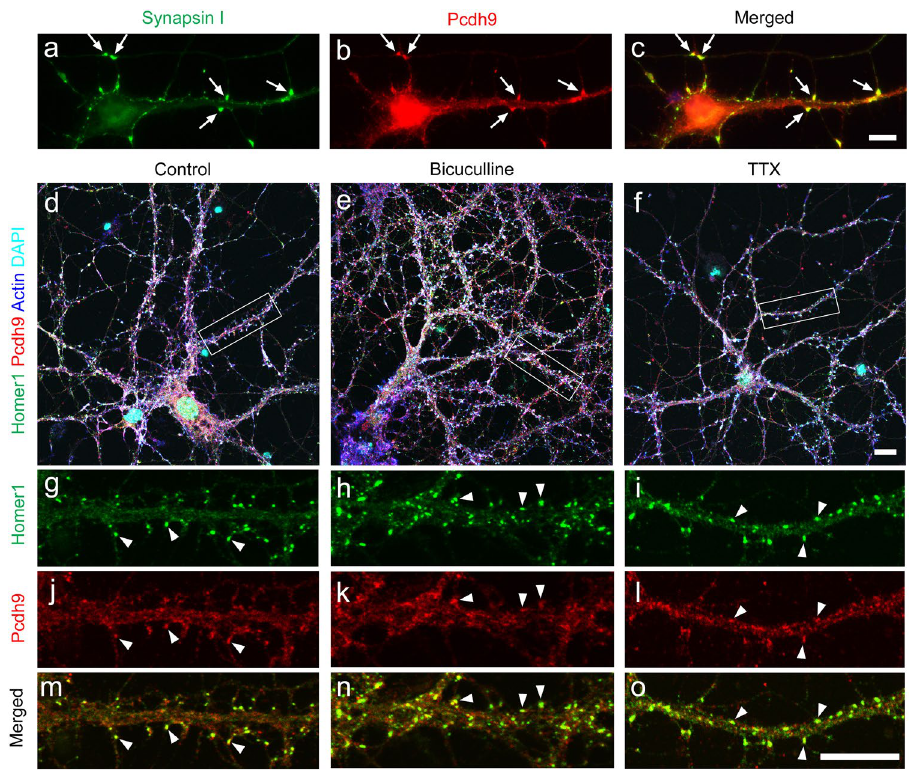
Figure 3. Localization of Pcdh9 proteins in cultured hippocampal neurons. ( a–c ) In 5-days in vitro (5-DIV) cultures, Pcdh9 protein was often localized at contact sites between neurites (arrows). ( d – o ) In 20-DIV cultures, Pcdh9 protein was often localized at synapses (arrowheads) in addition to other regions of neurites. Synaptic localization was not changed in normal medium ( d , g , j , m ), medium containing bicuculline ( e , h , k , n ), and TTX ( f , i , l , o ). Scale bars, 10 μm in ( a – c ), 10 μm in ( d–f ) and 10 μm in ( g–o